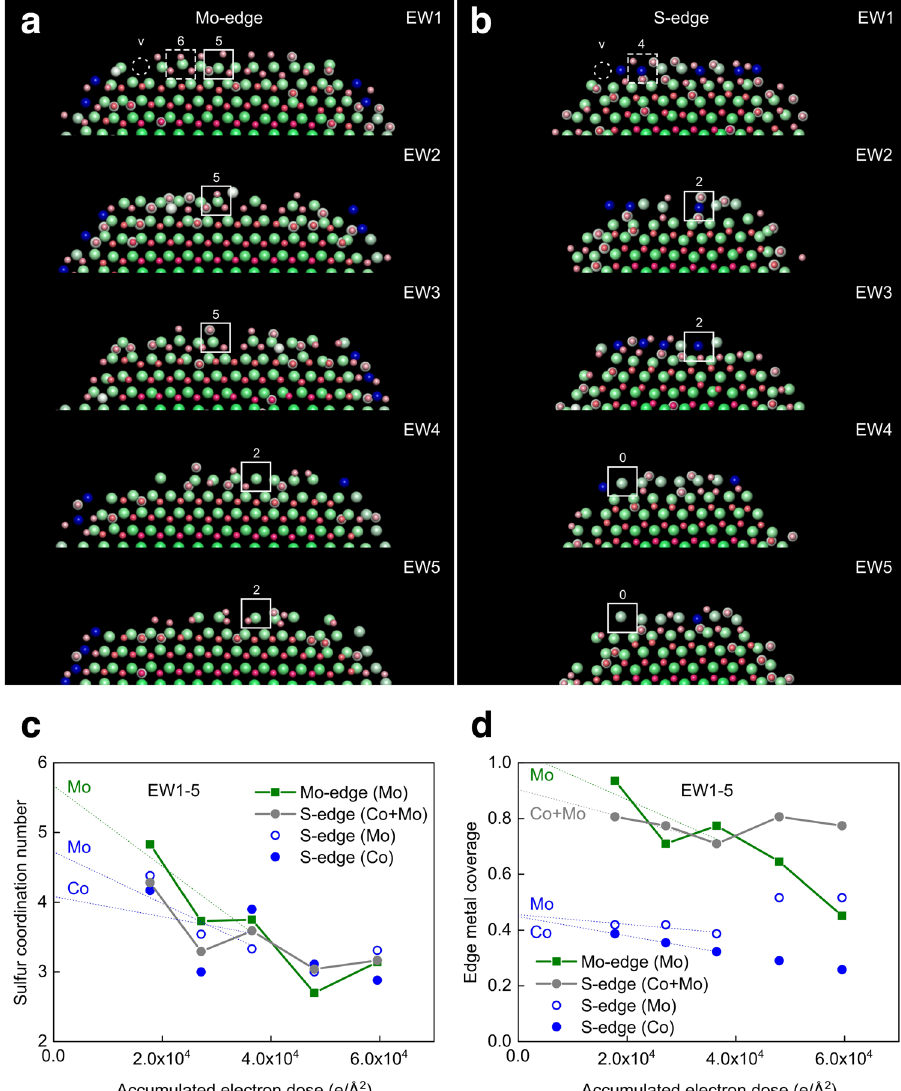
Fig. 4 Temporal edge motifs on the single-layer Co-Mo-S nanocrystal. a – b Close-ups of Mo- and S-edges of the 3D atom-dynamic images in Fig. 3. Each edge site is characterized by the metal atom and its number of coordinating sulfur atoms (Supplementary Fig. 11). Examples are highlighted by the superimposed boxes (solid lines: motifs with S-coordination that remain in successive 3D images, dashed lines: motifs with S-coordination similar to equilibrium structures predicted by density functional theory calculations 26,27,37 – 39 .). The v denotes a metal vacancy. c Average S coordination number for the Mo atoms at the Mo-edge and Mo and Co atoms at the S-edge shown versus electron dose. d The fraction of metal atoms at the Mo- and S-edge, respectively, versus electron dose. The atomic fraction is normalized to the number of metal atoms at the Mo-edges and S-edges, respectively, of a fully edge-decorated Co – Mo – S nanocrystal (Supplementary Fig. 11). Superimposed lines (dotted) indicate best linear fi t to the data obtained from the low dose rate images (EW1-3) in ( a ) and ( b ). Moreover, the electron dose is indicated for the center frame in the corresponding focus